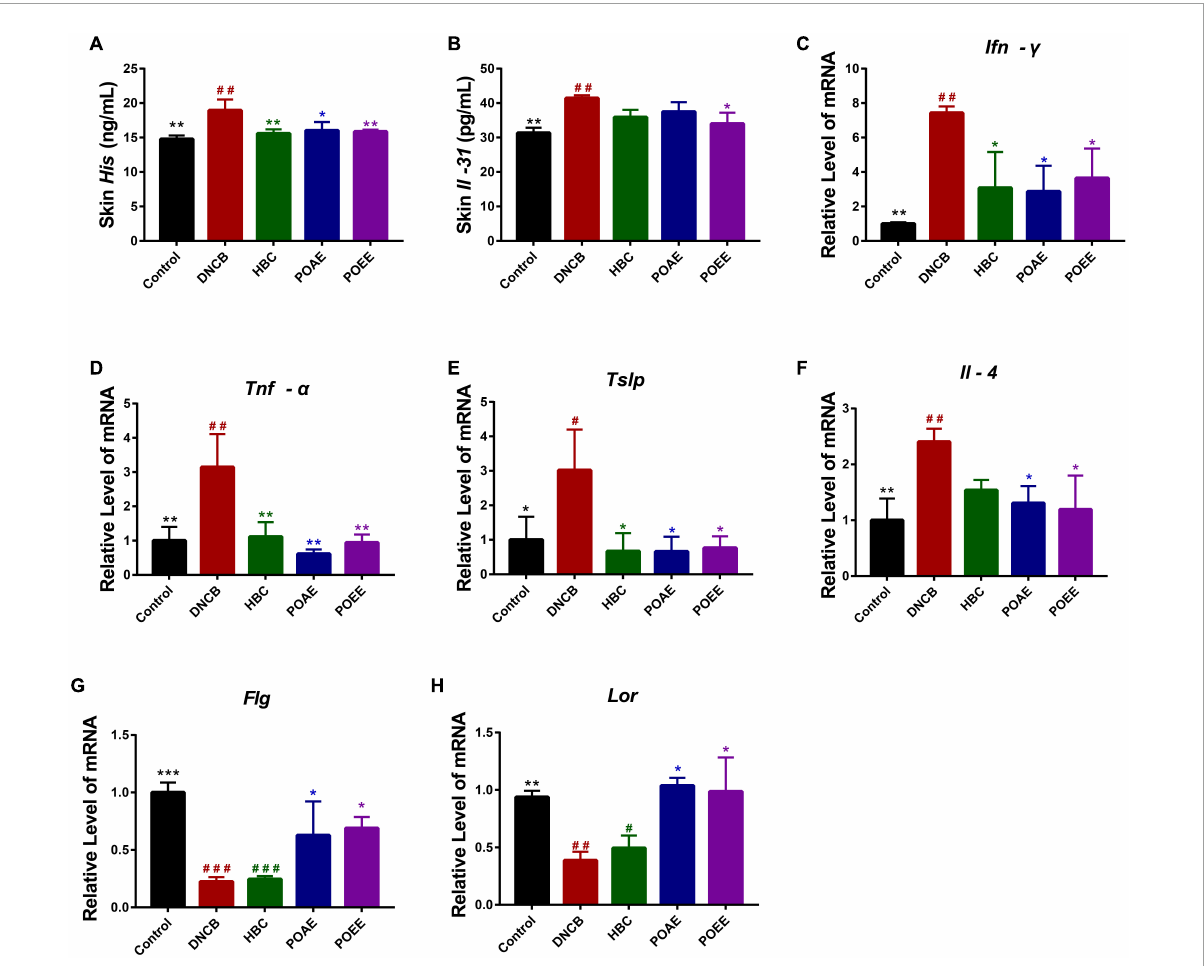
FIGURE5 POAE and POEE inhibit skin lesions and pruritus-associated cytokines in AD mice. (A) Skin His concentrations in each group of mice. (B) Skin Il-31 concentrations in each group of mice. (C–H) Relative mRNA expression of Ifn- γ , Tnf- α , Tslp, Il-4, Flg, and Lor in each group of mice. The data were expressed as mean ± SD ( n = 3 per group). # P < 0.05, ## P < 0.01, ### P < 0.001, vs. control groups; * P < 0.05, ** P < 0.01, *** P < 0.001, vs. model (DNCB)